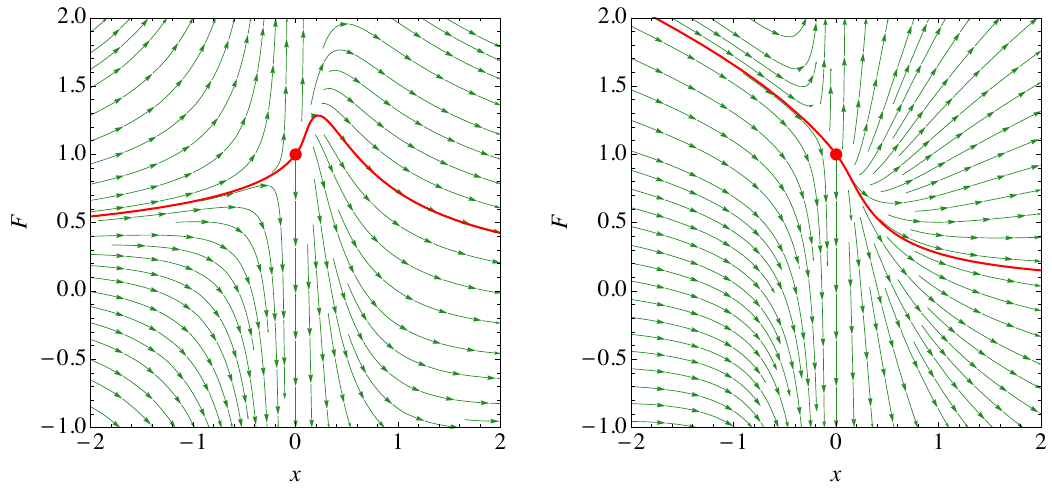
Figure 2 . In these plots we show the phase maps corresponding to p = 1 (left) and p = (cid:0) 1 (right) of the associated autonomous system. We also highlight the unique solution that smoothly goes through the critical point ( x = 0 ; F = 1) (red dot) from the left. Notice however that the continuation in the right is not uniquely determined due to the existence of a centre manifold that can be clearly appreciated in the plots. We have simply singled out one of